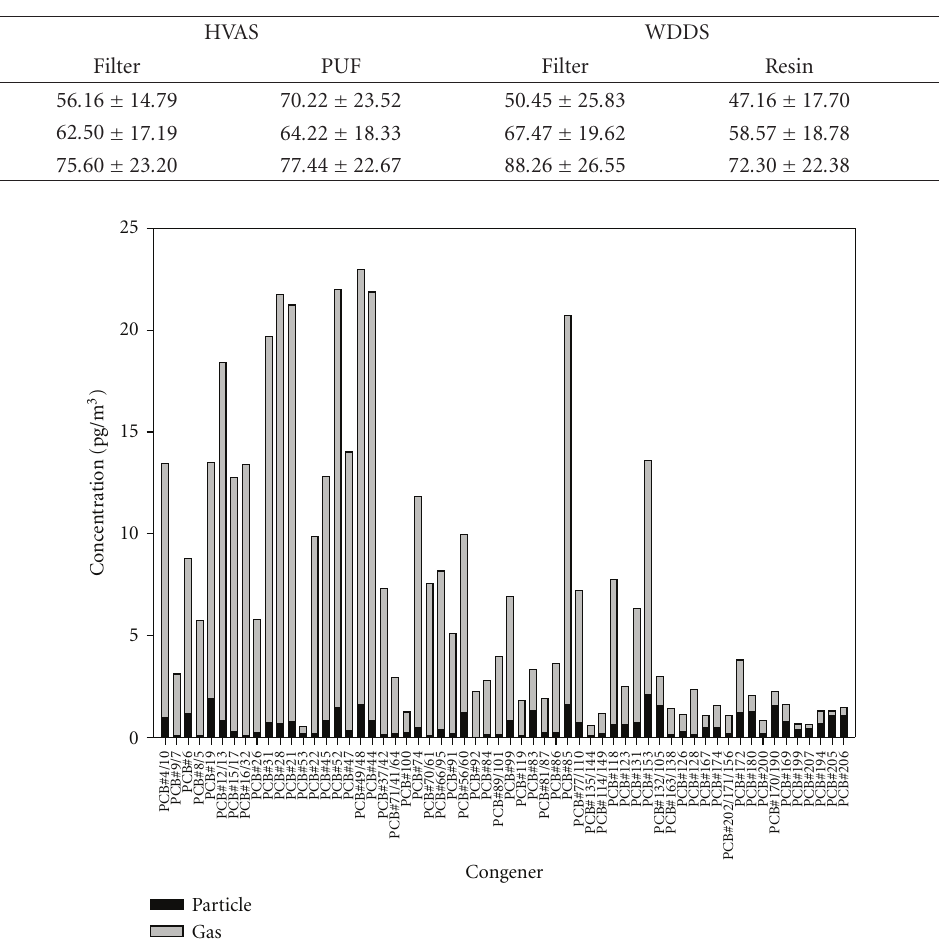
Figure 2: Distribution of the average gas/particulate concentrations of the PCB